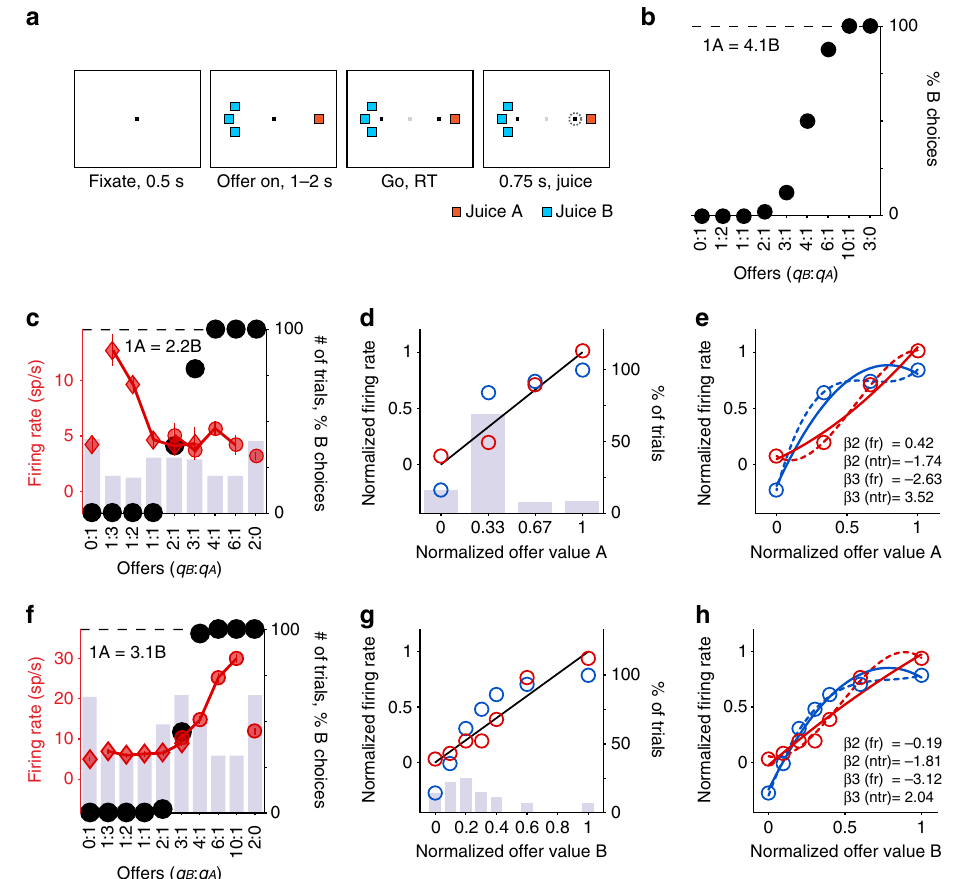
Fig. 1 Quasi-linear coding of offer values, individual responses. a . Task design (see Methods). b . Example of choice pattern. The x -axis represents different offer types, ranked by the ratio q B : q A . Black dots represent the percent of “ choice B ” trials. c . Example offer value A response. Black dots represent the choice pattern. The histogram illustrates the number of trials presented for each offer type. Red symbols represent fi ring rates ± SEM (diamonds and squares for “ choice A ” and “ choice B ” , respectively). The y -axis on the left refers to fi ring rates. The y -axis on the right refers both to the number of trials (histogram) and to the choice pattern (black symbols). d . Comparing fi ring rates and ntrials CDF . Same response as in c . The x -axis represents normalized quantity levels of juice A. The histogram illustrates the percent of trials for each quantity level. This session included 247 trials, and juice A was offered at quantity levels 0 (39 trials, 16%), 1 (169 trials, 68%), 2 (19 trials, 8%), and 3 (20 trials, 8%). Note that low quantity levels were over-represented. Blue circles represent the cumulative distribution function for the number of trials (ntrials CDF ). The y -axis on the right refers both to the number of trials (histogram) and to ntrials CDF (blue circles). Red circles represent fi ring rates. Here each neuronal data point is an average across all the trials with given quantity level (not across a single trial type). The y -axis on the left refers to normalized fi ring rates. Limits on the y -axes were set such that the same line (black) represents the best linear fi t for fi ring rates and for ntrials CDF . (Because all measures are normalized, this is the identity line.) e . Curvature of fi ring rates and ntrials CDF . Same data points as in d . Continuous and dotted lines are the result of the quadratic and cubic fi t, respectively. f – h . Example offer